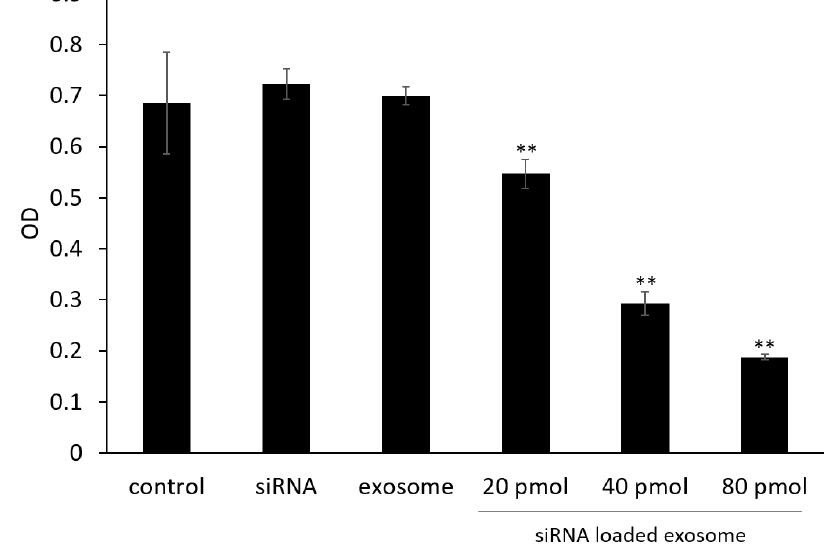
Figure 3. Proliferation rates of B16/BL6 cells treated with siRNA-loaded exosomes at various siRNA concentrations. Data represent the mean ± SD of three independent experiments; ** p < 0.01 versus the control group (Bonferroni